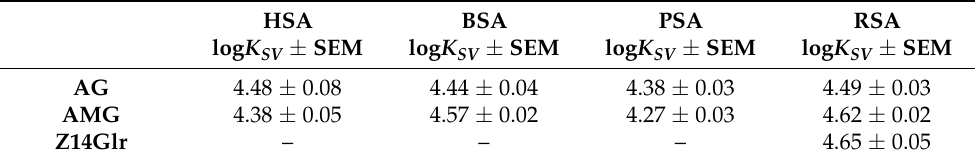
AG, alternariol-3-glucoside; AMG, alternariol-9-monomethylether-3-glucoside; Z14Glr, zeara-lenone-14- glucuronide; HSA, human serum albumin; BSA, bovine serum albumin; PSA, porcine serum albumin; RSA,